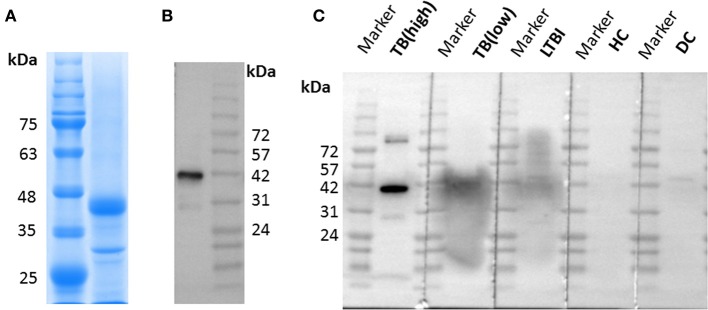
Expression and identification of LppZ protein. (A) SDS-PAGE analysis of purified LppZ protein expressed in E. coli. LppZ was purified by Ni-NTA column and applied to 12% SDS-PAGE. LppZ protein was visualized through staining with Coomassie brilliant blue. (B) Western blotting of purified LppZ protein. Purified His-tagged LppZ was detected with HRP conjugated anti-6 × His tag mouse antibody. (C) Western blotting of purified LppZ protein. Purified LppZ was detected with plasma from two TB patients, one LTBI individual, one HC, and one disease control (DC).